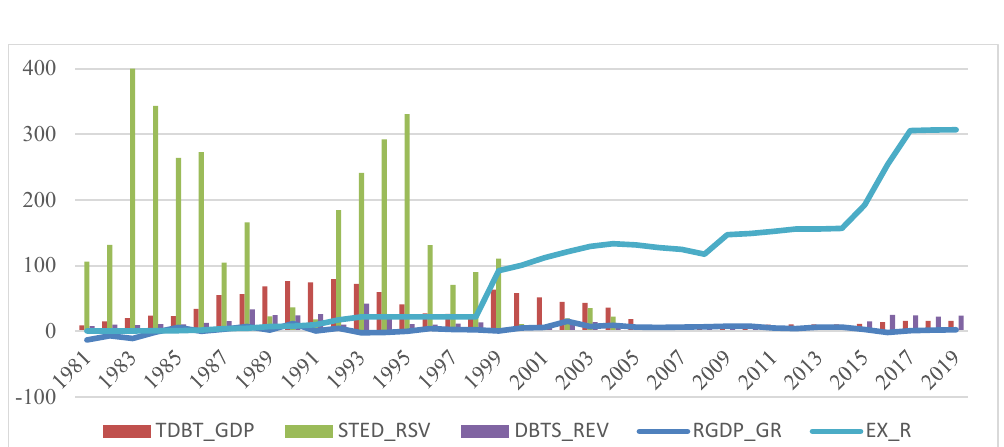
Fig. 4. Trend plot of data series used for the analysis (Central Bank of Nigeria, 2019; World Bank, n. d.).